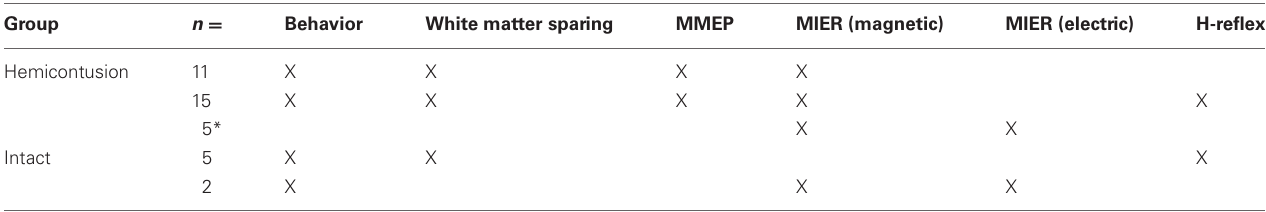
Table 1 | Number of animals in behavioral, electrophysiological, and histological section of the study. Group n = Behavior White matter